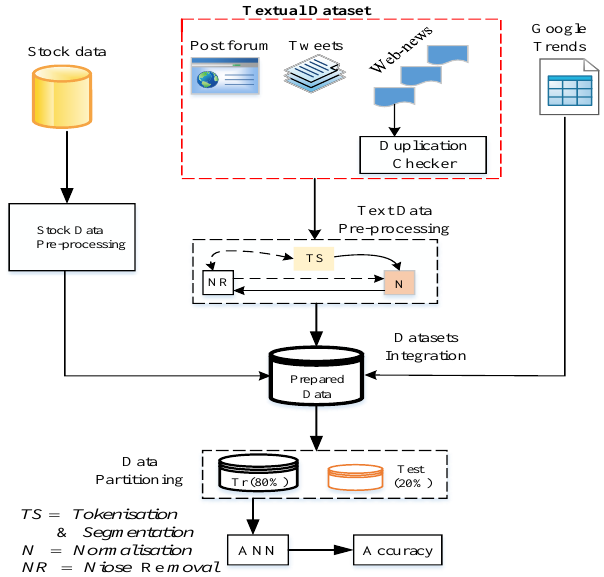
Fig. 1. Data pipeline of the